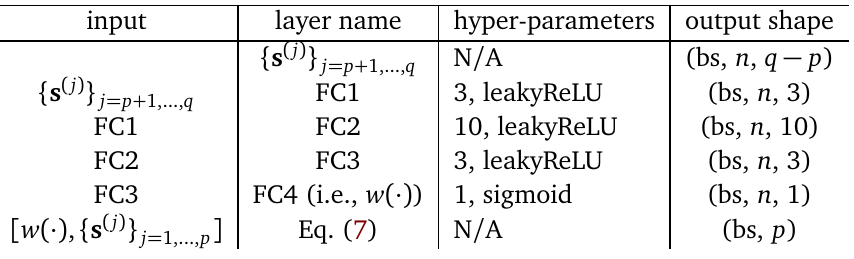
Table 3: Decoder architecture of INCA. Fully connected (FC) layer details correspond to number of hidden units, and activation, respectively. All leakyReLU activations have their α = 0.3. Output shapes are listed for an initial observation length of 200 steps constructed using noise vector ε ∈ (cid:82) 200 × c ε having c ε channels. Minibatch size is denoted as bs. { s ( j ) } corresponds to auxiliary summary statistics. For more j = p + 1,..., q details, please refer to our